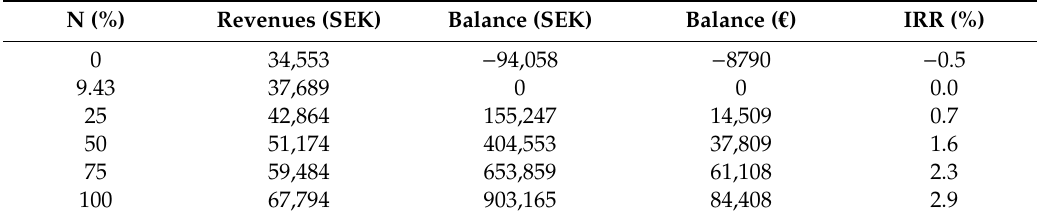
Table 2. Annual revenues, lifetime balance and Internal Rate of Return (real) of the investment by di ff erent prices set by the